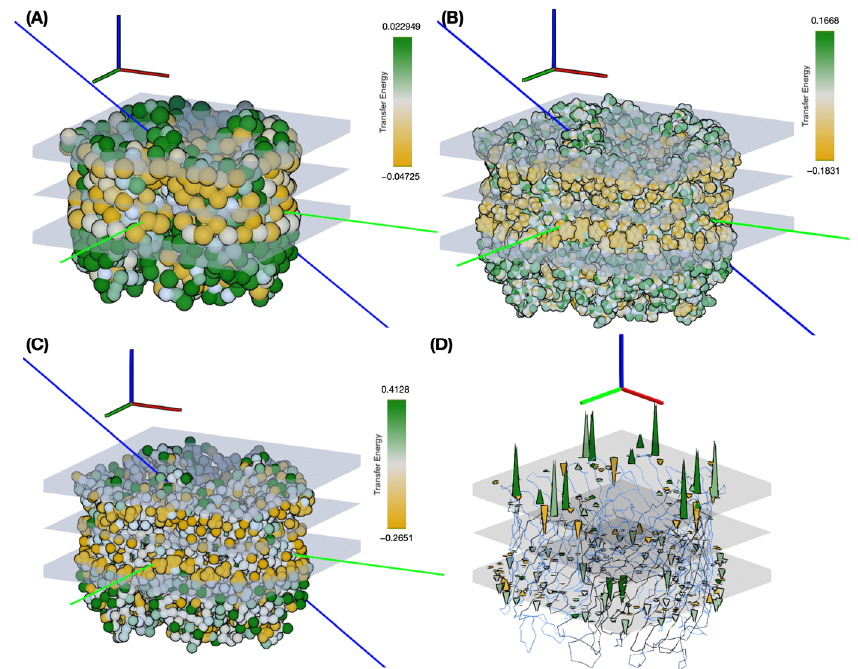
Figure 10. Interactive membrane insertion of maltoporin at different scales of representation. ( A – C ) Particles are colored according to their transfer energies, ranging from orange (lowest and negative energy if hydrophobic) to green (higher energy and positive if hydrophilic) to white for intermediate values. This color code was chosen to facilitate visual comparison with the original publication [19]. The implicit membrane is shown with the two interfacial regions and the z = 0 Å planes in gray. The blue vector is the insertion vector passing through the two particles T40 (CA) and Q48 (CA). ( A ) Levitt representation with one bead per residue. ( B ) All atom representation with calibrated UNILIPID transfer energy values fitted using the method described in Table S2 of S3.1 in the Supplementary Data. ( C ) The Martini 3 representation shows the energies fitted to the octanol distribution values multiplied by the theoretical surface areas of the grains. ( D ) The same system and simulation setup as in ( C ), with the forces applied to the particles represented by colored spikes. The force amplitude is proportional to the length of each spike and the color represents the transfer energy of the corresponding particle. In fact, the forces are always directed orthogonally to the surface of the membrane on the plane of the